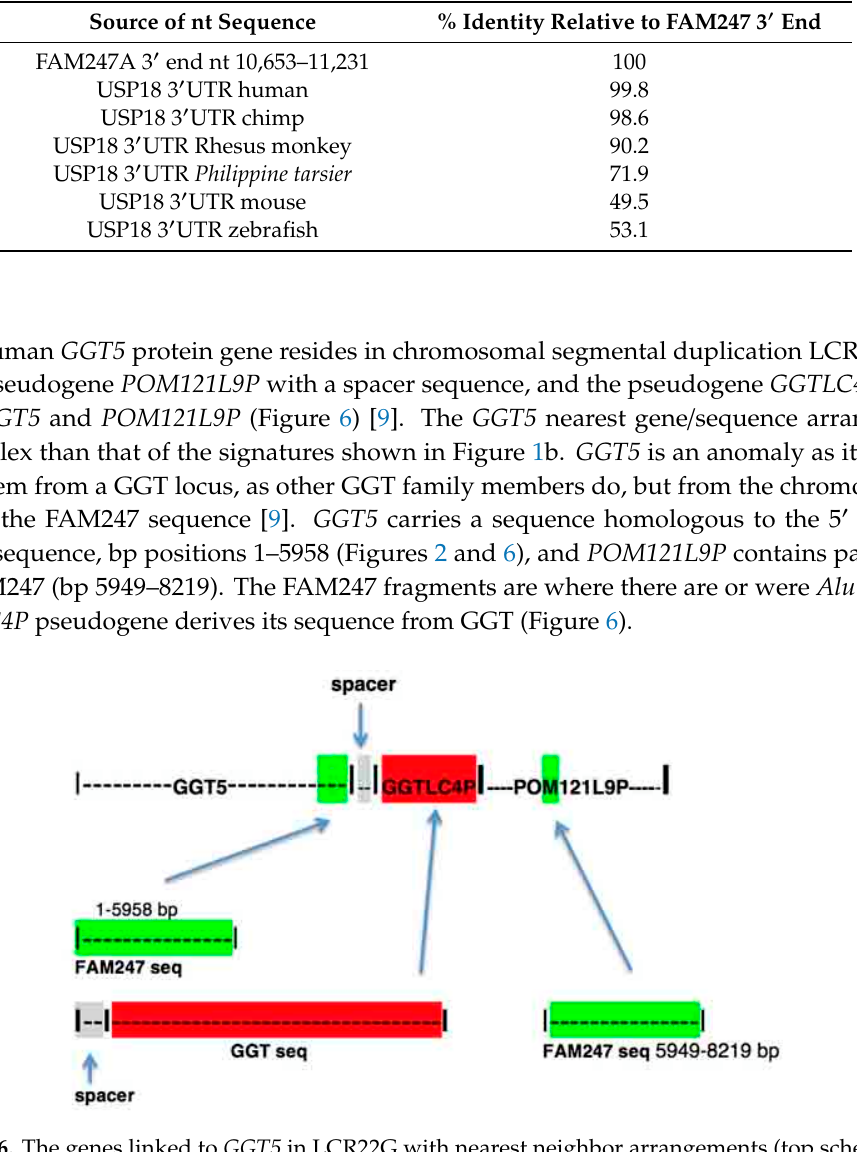
Figure 6. The genes linked to GGT5 in LCR22G with nearest neighbor arrangements (top schematic) and the source of sequences found in human-linked genes GGT5–GGTLC4P–POM121L9P . GGT5 and POM121L9P appear to have been formed at very different evolutionary